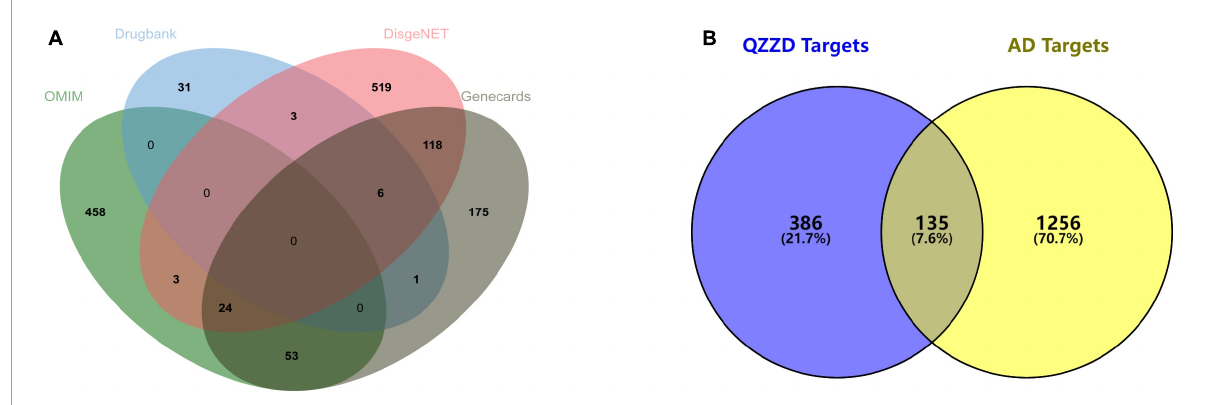
FIGURE2 Venn diagram. (A) Venn diagram of AD-related targets from the DisGeNET database, OMIM database, Drugbank database and GeneCards database. (B) Venn diagram of 135 common targets between QZZD and AD.